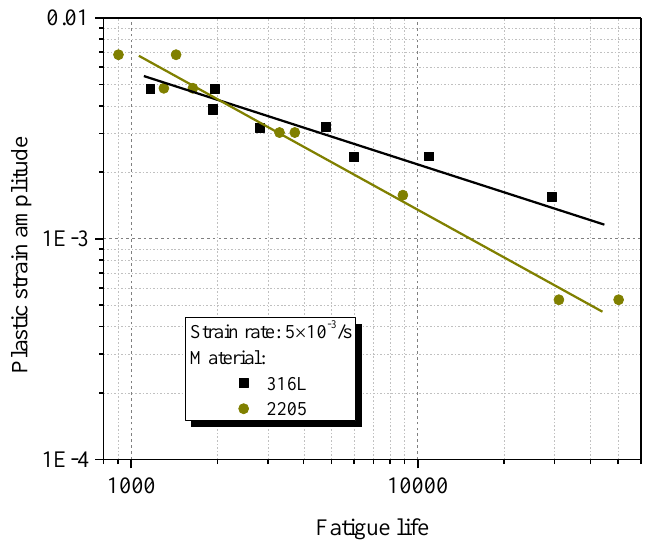
Figure 12. Relationship between fatigue life and plastic strain amplitudes.